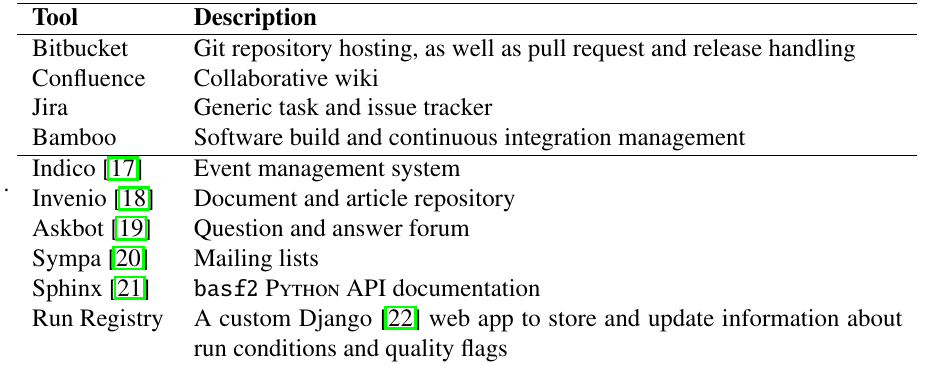
Table 1. Some examples of collaborative services hosted by DESY. The first four are bundled as part of the Atlassian tools